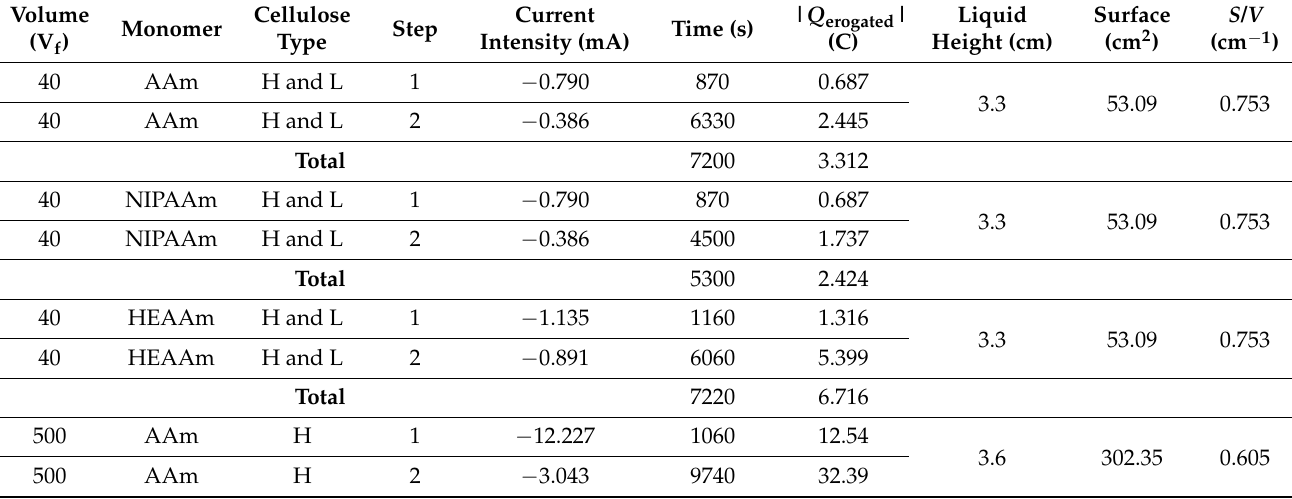
Table 4. Electrolysis programs, geometrical reactors details for the candidate polymerization up to 1000 mL (scale-up factor ~67). a.